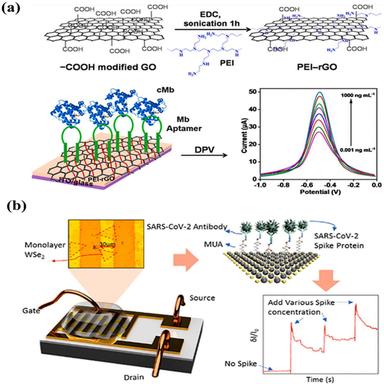
(a) Schematics for the fabrication of a label-free aptameric sensing platform (aptasensor) for detecting cMb. Reproduced with permission and (b) Construction of a monolayer WSe2 FET COVID sensor. Immobilisation of SARS-CoV-2 antibody monolayer on WSe2 crystals using 11-mercaptoundecanoic acid (MUA), and interdigitated electrodes were constructed on the crystals for sensing. Reproduced with permission.